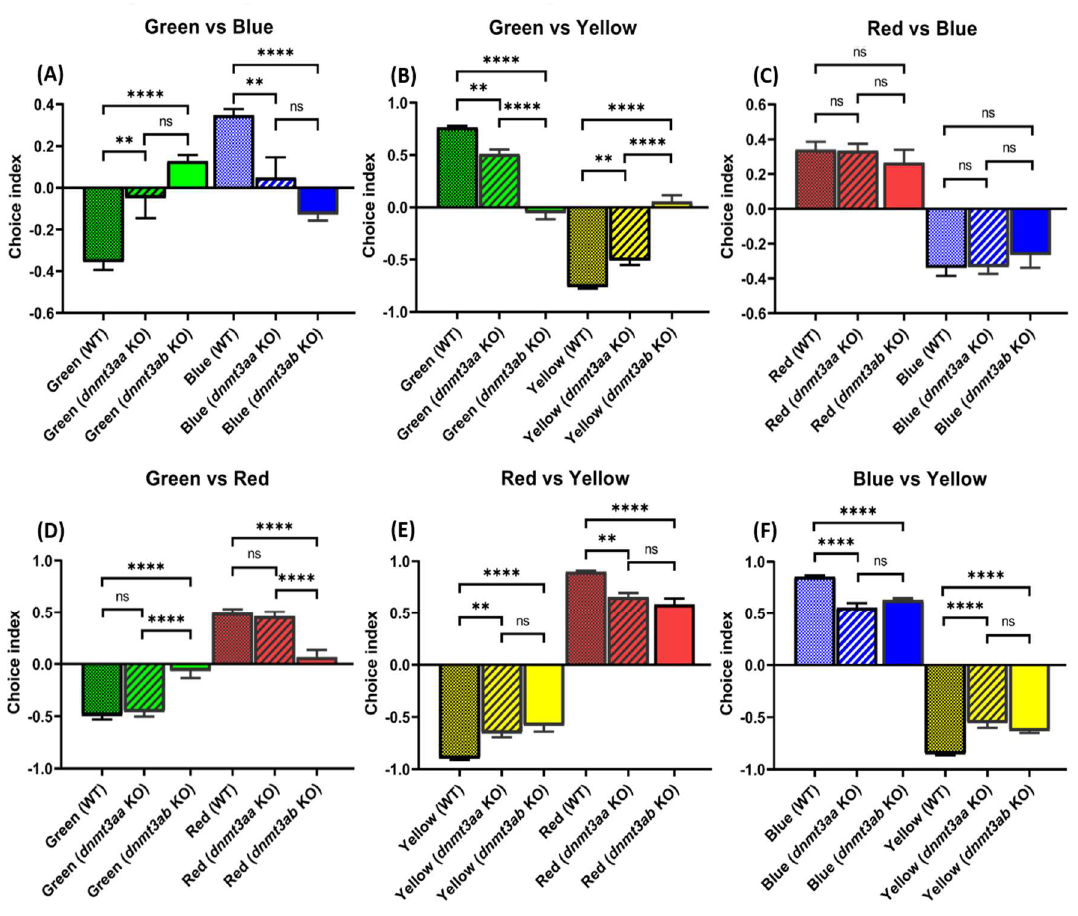
Figure 9. Comparison of color preference ranking and index between wild type, dnmt3aa KO, and dnmt3ab KO mutant zebrafish: ( A ) green vs. blue combination; ( B ) green vs. yellow combination; ( C ) red vs. blue combination; ( D ) green vs. red combination; ( E ) red vs. yellow combination; and ( F ) blue vs. yellow combination. Data were analyzed with one-way ANOVA followed by Tukey post-hoc test. The data were presented as mean ± S.E.M. ( n = 24, ** p < 0.01, **** p < 0.0001) .